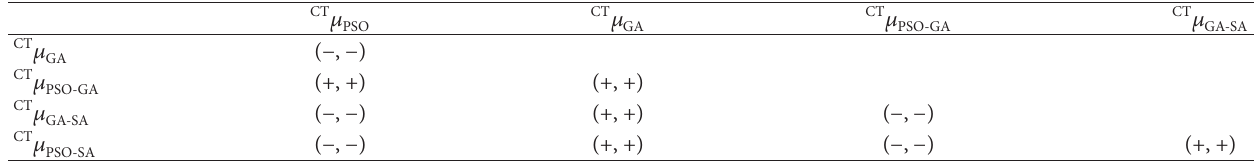
Table 7: Multiple comparison on convergence